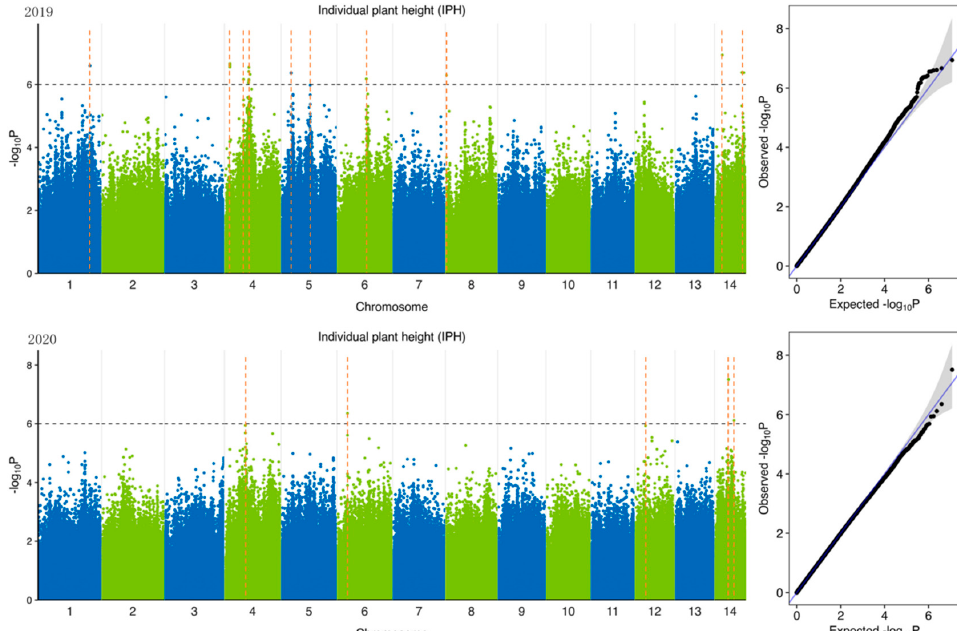
Figure 5. Manhattan plots of GWAS results for fresh weight per clump (FWPC) in 2019 and 2020. Notes: Blue and green dots represented SNP (single nucleotide polymorphism) sites on chromo- somes, respectively. When the value of − log 10 p was above 6 (gray line), the selected SNP site with significant aboriginality. Orange dotted lines represented the location of SNP loci.